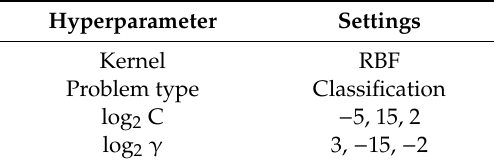
Table 6. Support vector machine (SVM) classifier—hyperparameter